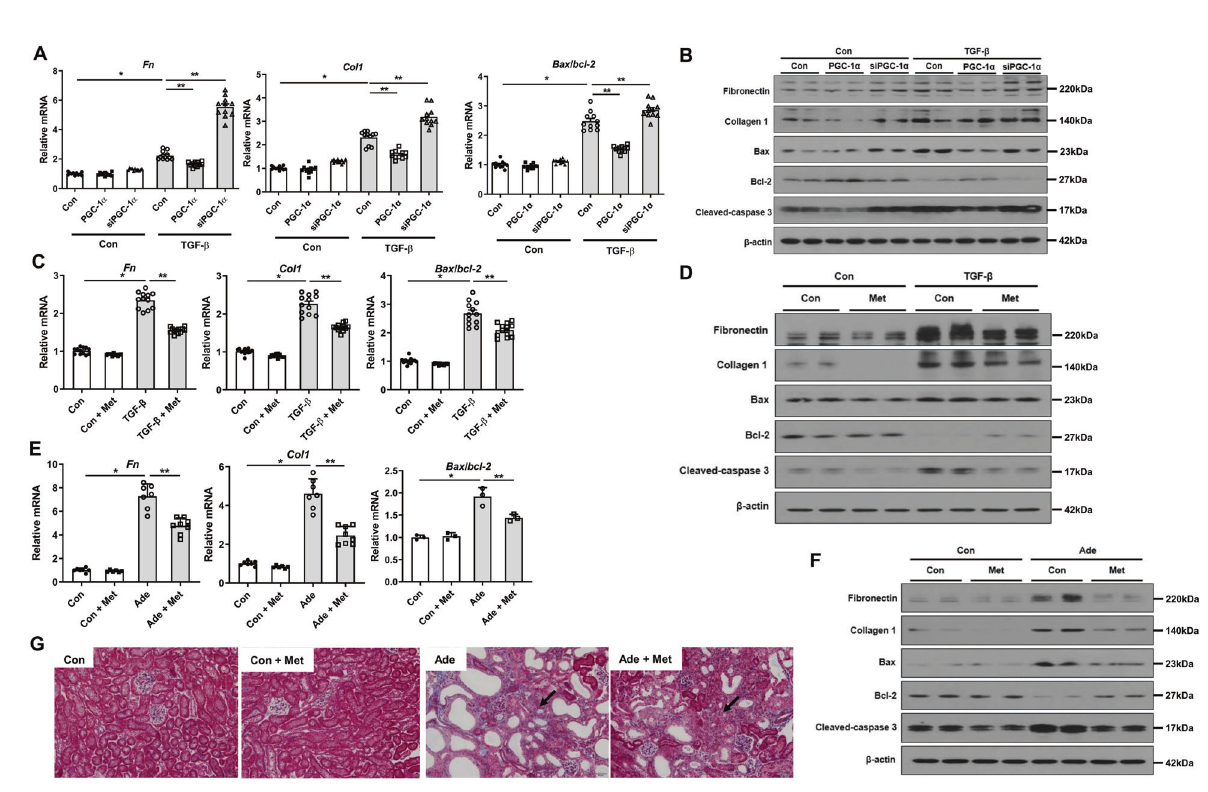
Fig. 4 PGC-1 α restores cell injury. A – F mRNA and protein expression of fi brotic and apoptotic markers were attenuated in TGF- β 1-treated RTECs with overexpression of Ppargc1a and metformin, whereas exacerbated by siPGC-1 α . G Degree of kidney fi brosis by Masson ’ s trichrome staining was attenuated in adenine-fed mice with metformin. Note: * P < 0.05 vs. control; ** P < 0.05 vs. TGF- β 1-treated RTECs or adenine-fed mice. PGC-1 α peroxisomal proliferator- γ coactivator-1 α ; RTEC renal tubular epithelial cell; Ade adenine; Met